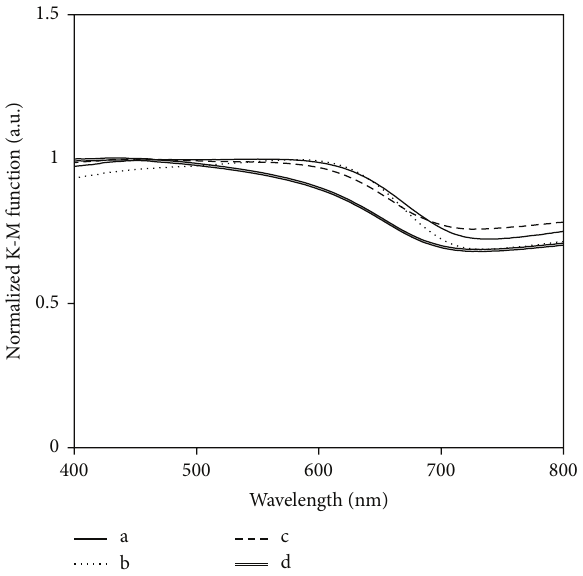
Figure 4: UV-Vis diffuse reflectance spectra of LaNbON 2 synthe- sized by the ammonothermal method and the conventional method. (a) Undoped, (b) Sr-doped, (c) Ti-doped LaNbON 2 synthesized by the ammonothermal method, and (d) LaNbON 2 synthesized by the conventional method.